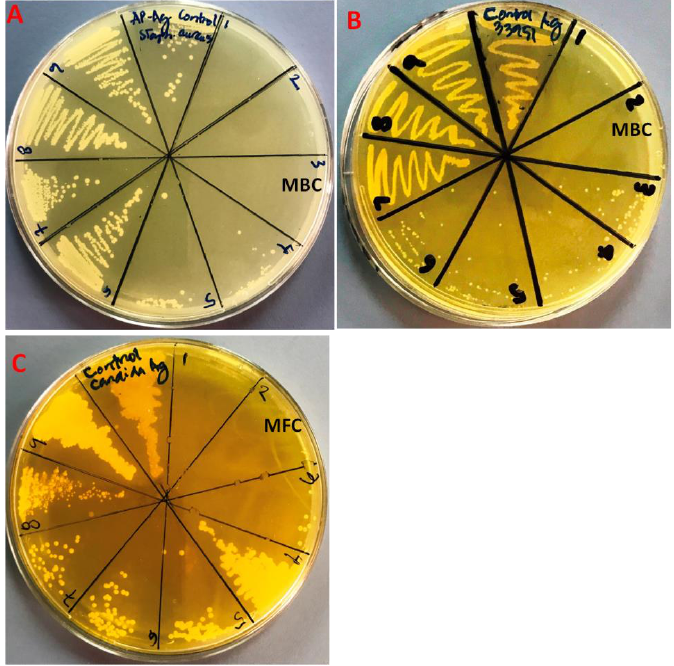
Figure 7. Agar plates showing MBC values of AP-AgNPs against Gram-positive bacteria ( A , B ) and fungi ( C ). ( A ) Represents S. aureus (ATCC 25923), ( B ) methicillin-resistant S. aureus and ( C ) represent